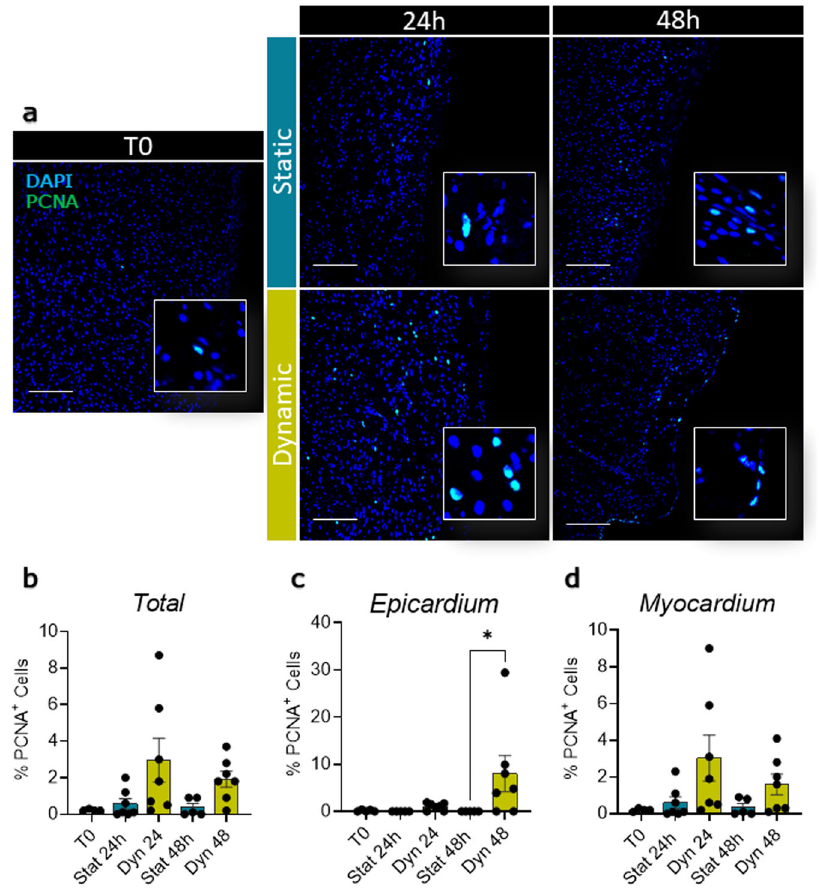
Fig. 5 Dynamic slice culture increases epicardial cell proliferation. Proliferation was evaluated by PCNA antigen staining. Representative confocal images ( a ) and proliferating cell fraction in the whole slice ( b ), the epicardial ( c ), and the myocardial area ( d ) show no effect in static culture (Stat) and an increase following dynamic culture (Dyn). N of pigs = 5 – 6, number of slices displayed in graphs. All graphs display data as mean ± SEM. * p ≤ 0.05. Scale bar, 100